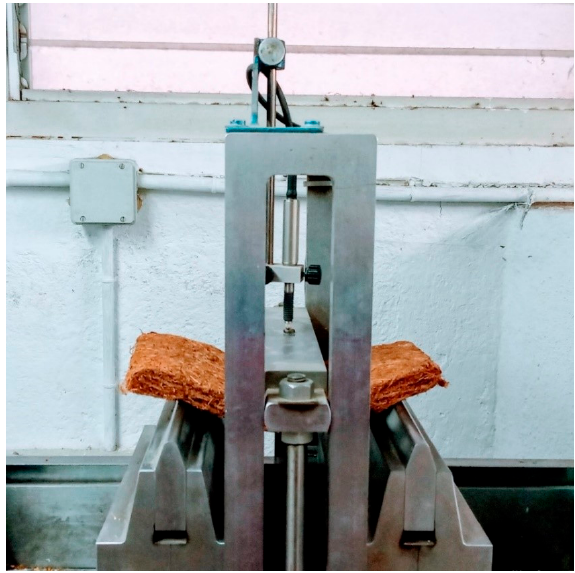
Figure 11. Flexural test set-up.